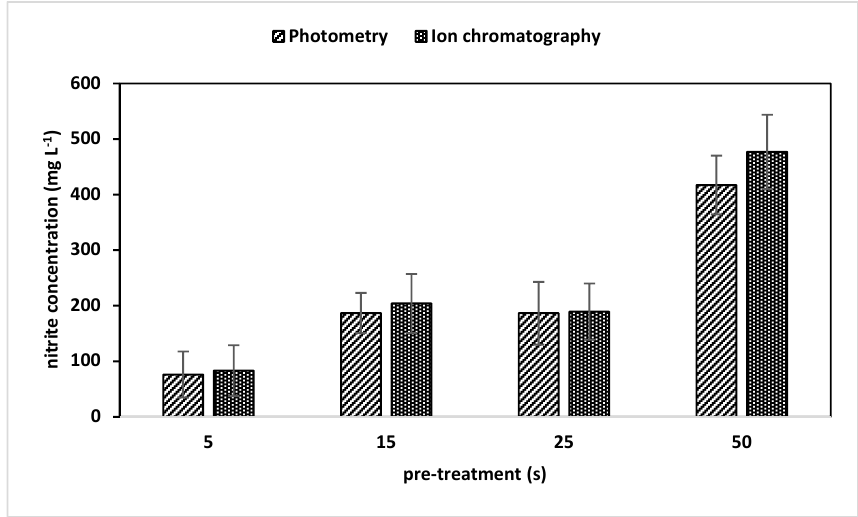
Figure 3. Nitrite concentrations (mg L − 1 ) of PTW (plasma-treated water) with pre-treatment time (plasma on) from five up to 50 seconds measured by photometry and ion chromatography. N = 10. Standard deviations are given be error bars.